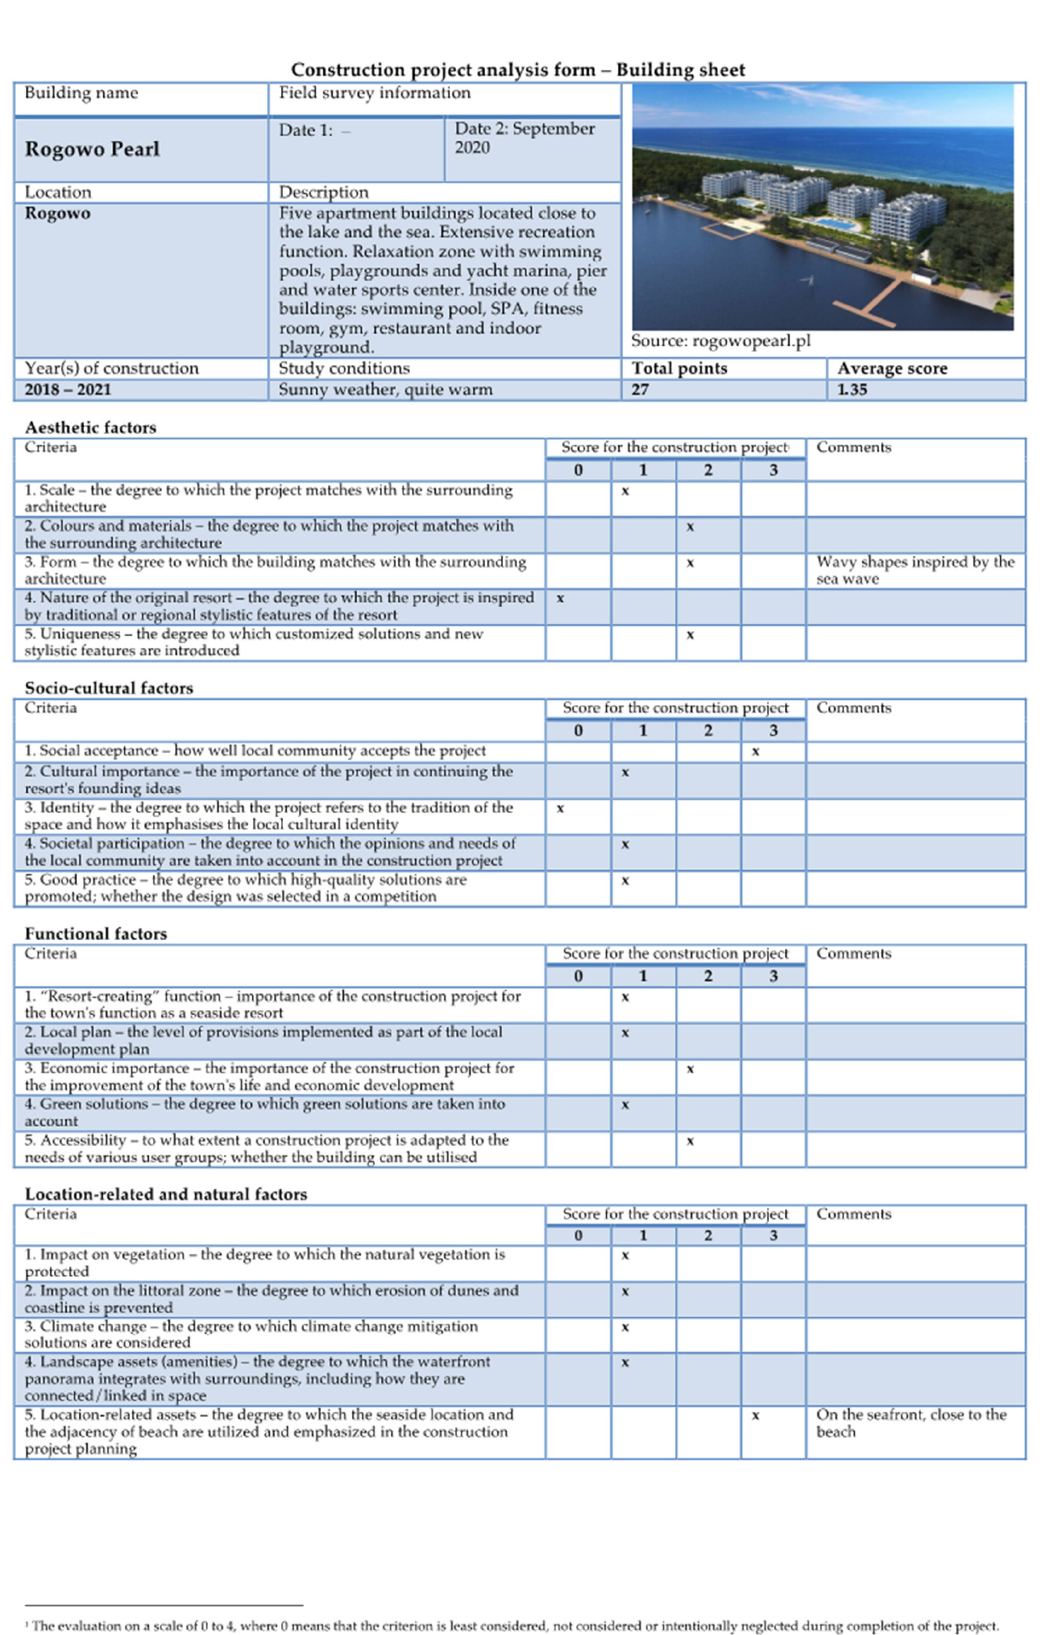
Figure A8 . Rogowo Pearl in Rogowo. Building sheet. Figure A8. Rogowo Pearl in Rogowo. Building